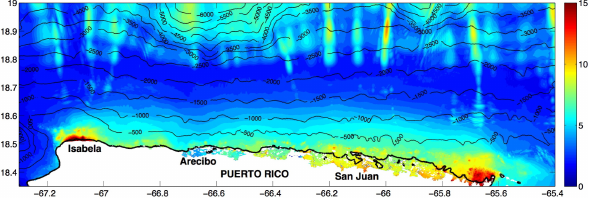
Fig. 7. Same simulation as in Fig. 6. Envelope of maximum surface elevation (in meters) calculated using FUNWAVE in a 3 00 model and bathymetric/topographic grid (Fig. 5). The thin black lines are isobaths marked in meters. The thick black line marks the mean coastline location (zero elevation) prior to tsunami arrival.